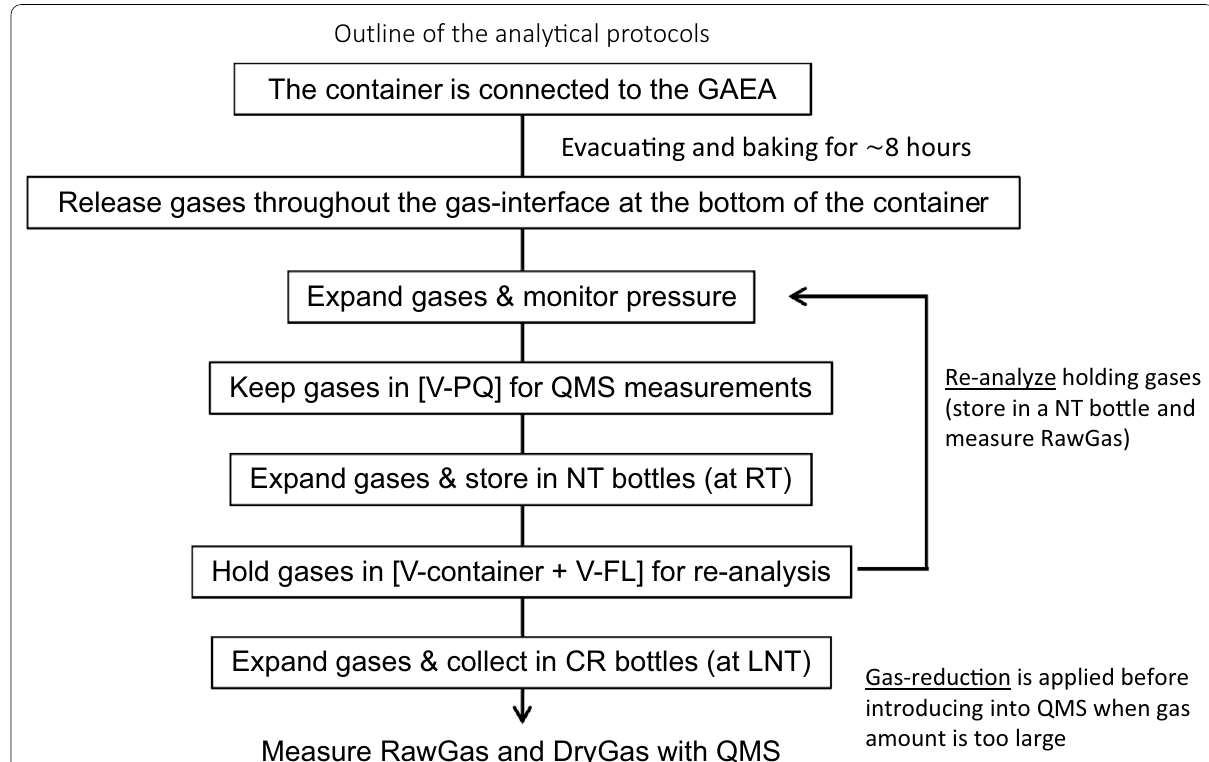
Fig. 9 An outline of the analytical protocols for extraction, storage, and measurements of volatile gases in the Hayabusa2 sample container. RawGas means gases without any separation processes. DryGas means remaining gases after trapping gases in gas bottles of CR #1 and #2 at the liquid nitrogen temperature. RT—room temperature, LNT—liquid nitrogen